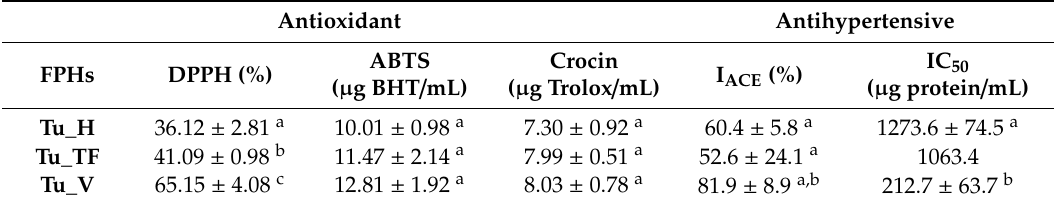
Table 5. Bioactivities of FPHs from turbot by-products. Errors shown are the confidence intervals for n = 3–5 (samples from independent hydrolysates) and α = 0.05. Di ff erent letters in each column means significant di ff erence between fish discards ( p <